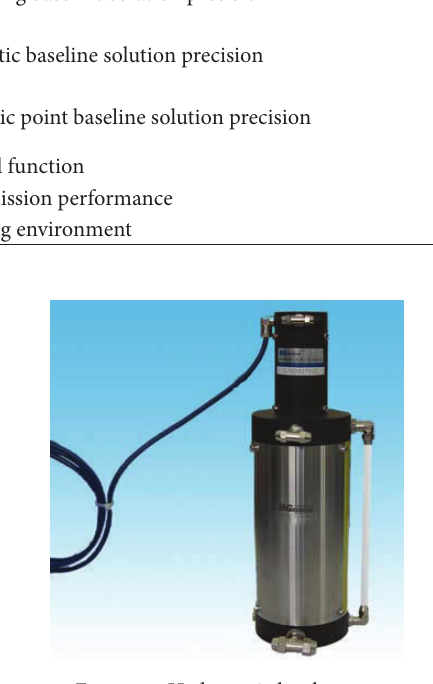
Figure 7: Hydrostatic level gauge.